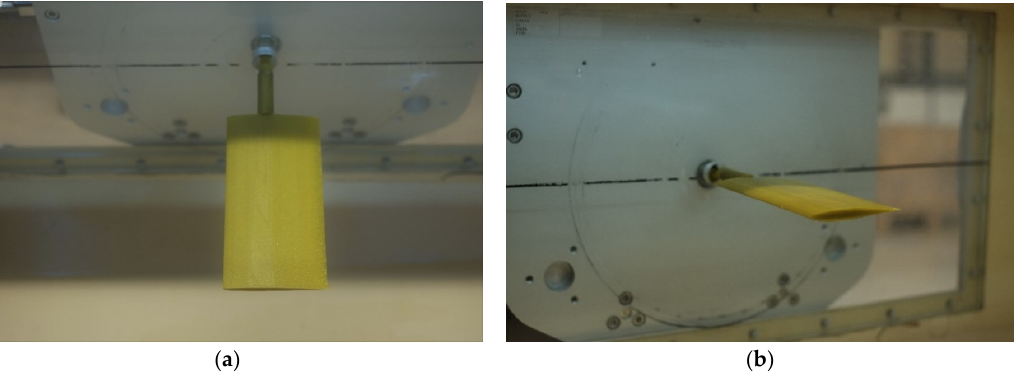
Figure 6. The wing mounted in the subsonic wind tunnel: ( a ) top view; ( b ) isometric perspective